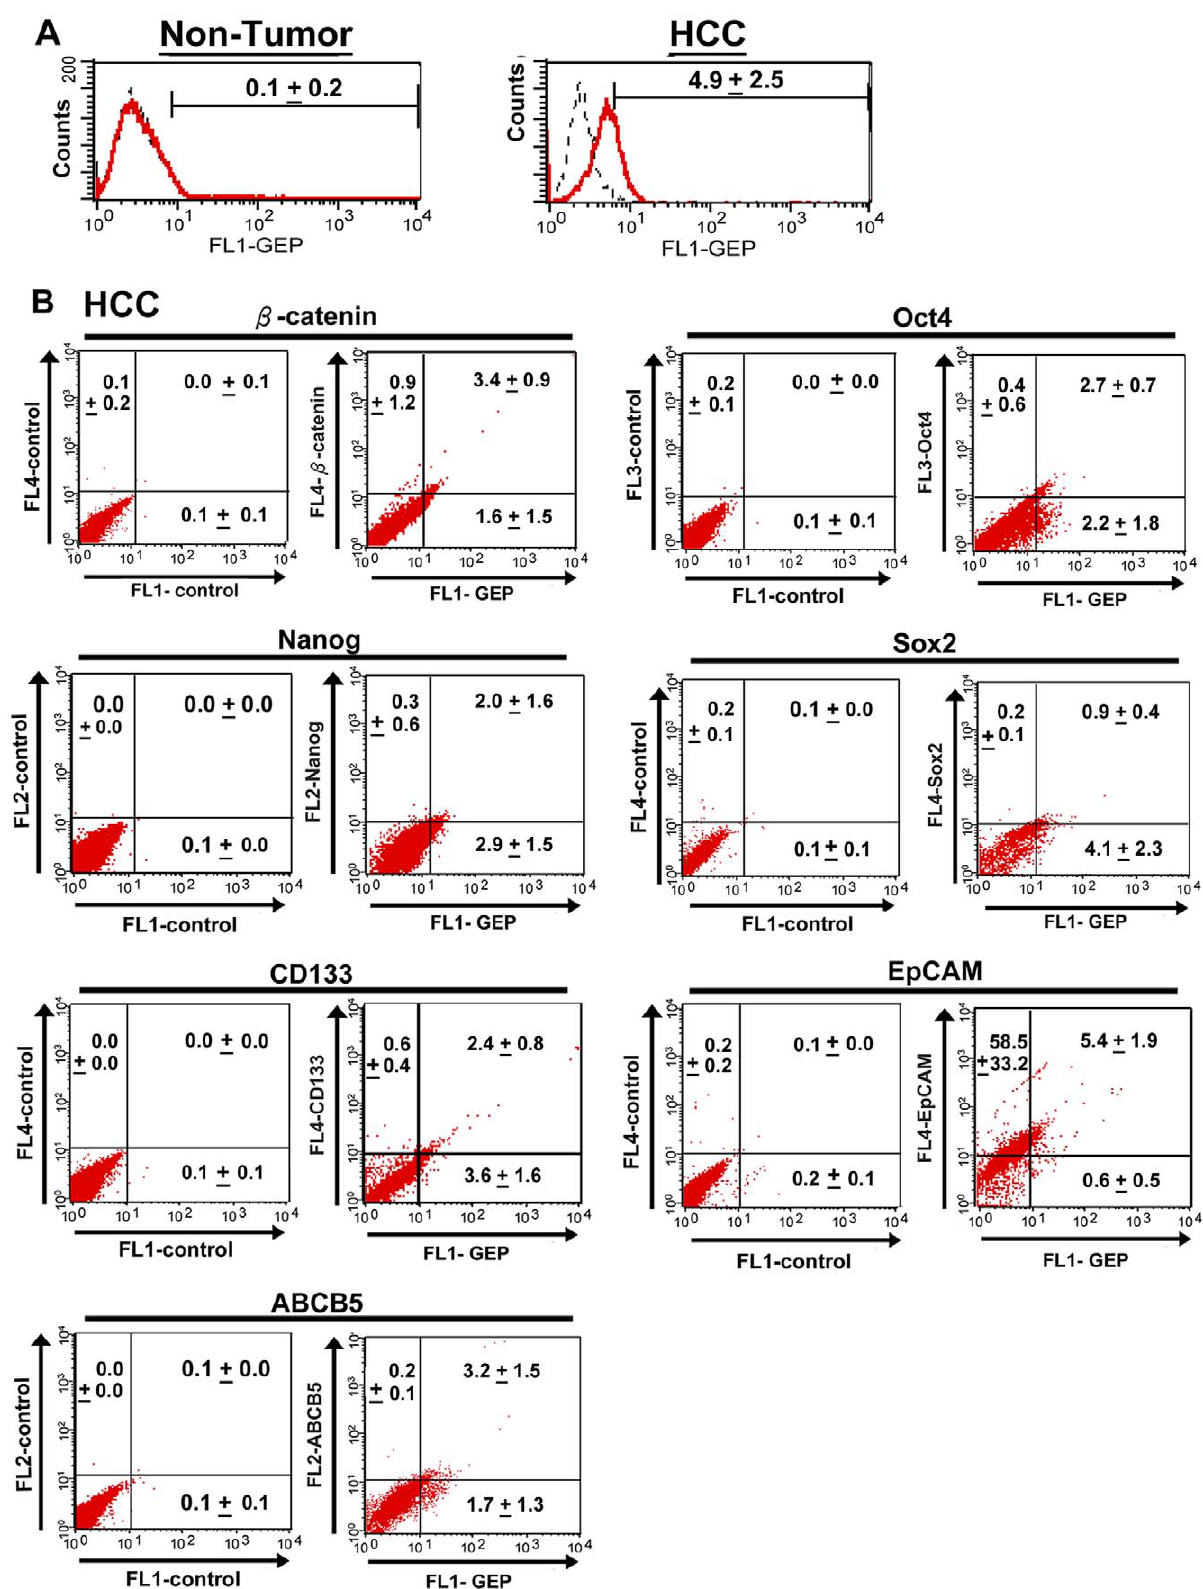
Figure 5. Phenotypic characterization of GEP-expressing cells in HCC clinical specimens. Liver tissues obtained from HCC patients were digested into single cell suspension, and assessed for the expression of albumin, GEP and stem cell markers. (A) Flow cytometric analyzes showing GEP expression in HCC, but not in adjacent non-tumor liver tissues. GEP expression analysis was performed by dual-color flow cytometry, gating on